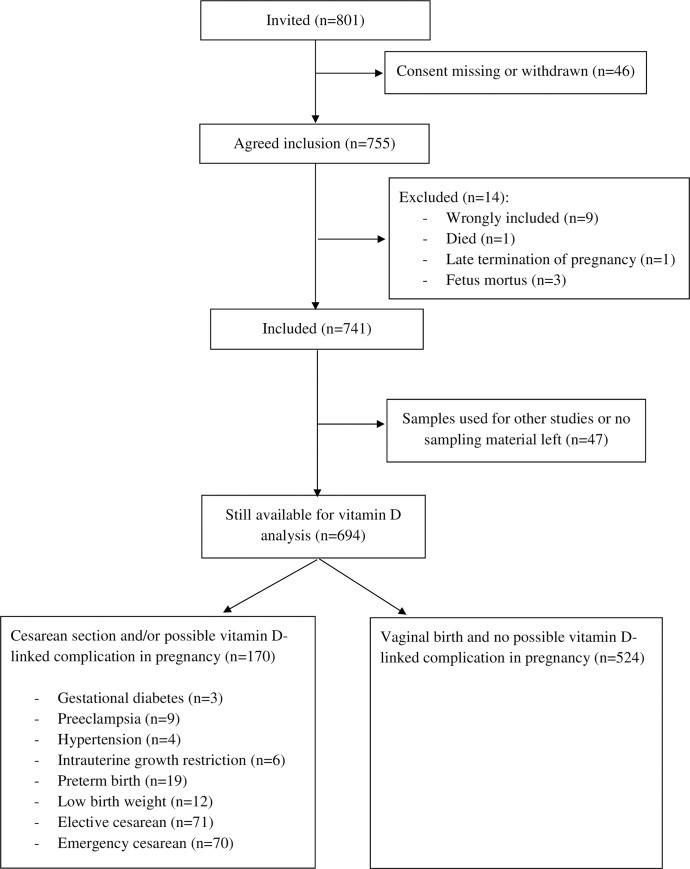
Consort flow chart.